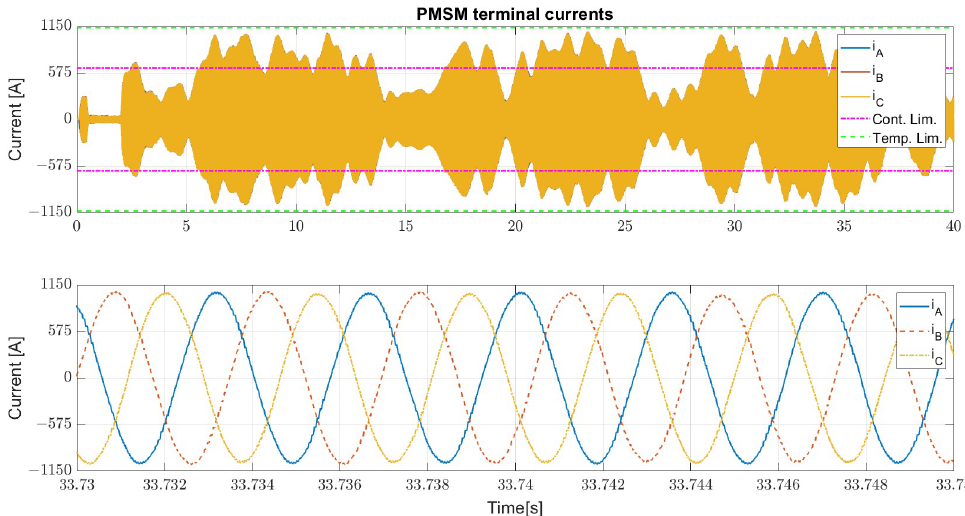
Figure 23. PMSM Currents.